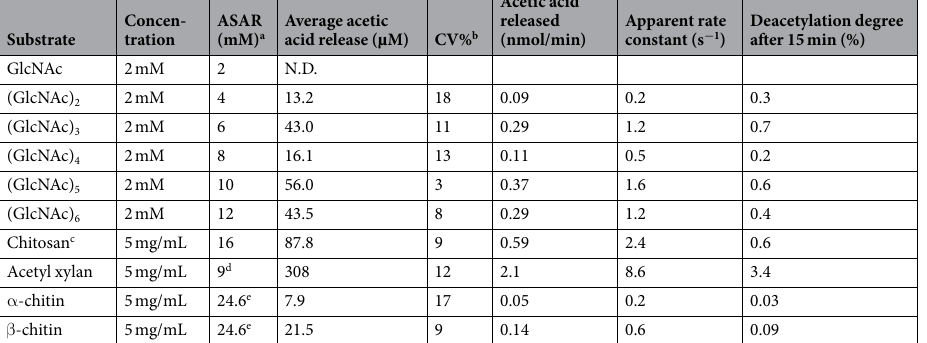
Table 1. Activity of An CDA. All of the substrates were incubated with 40 nM An CDA in a 100 μ L reaction volume for 15 minutes at standard reaction conditions. Note that under these conditions, the degree of deacetylation is very low, which implies that multiple deacetylations of oligomeric substrates are highly unlikely (see also below). a ASAR, substrate concentration expressed as the concentration of acetyl groups. b CV%, coefficient of variance. c Solubilized chitosan with degree of N-acetylation of 64% (F A = 0.64), with a random distribution of N -acetylated and de- N -acetylated units. d The acetate concentration was estimated after complete deacetylation with 50 mM aqueous NH 3 over night at 4 °C. e Assuming one acetylation per sugar